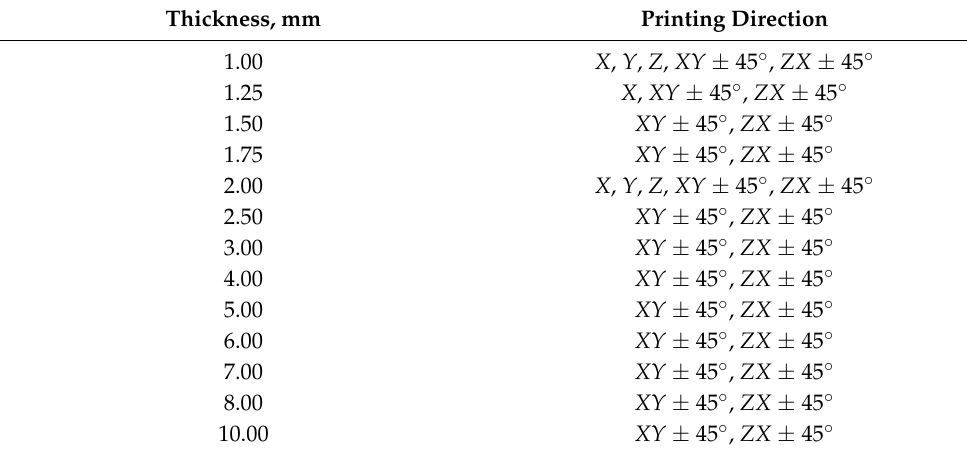
Table 1. Printing parameters for the test samples used in vertical burn